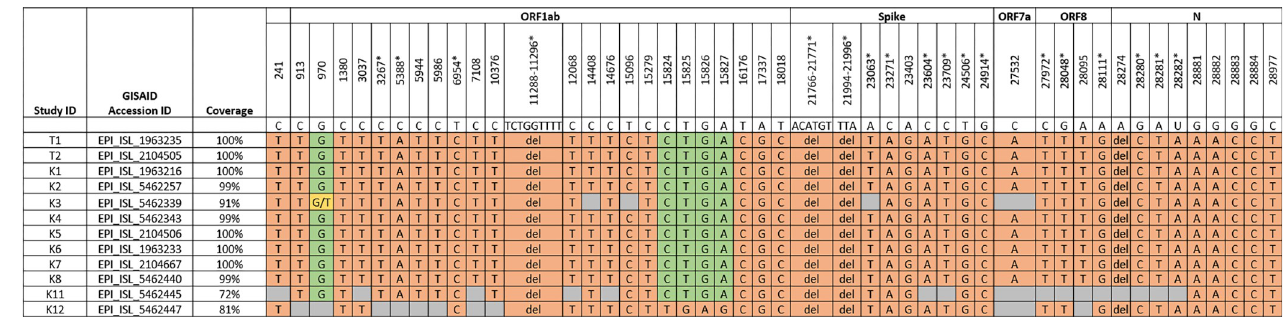
Fig 4. Virological analysis of positive cases by SARS-CoV-2 full genome sequencing. Mutations in comparison to the reference sequence (NC_045512) are highlighted in orange. Green fields indicate no mutation; grey fields indicate insufficient genome coverage; and yellow fields indicate mixed viral population of the two nucleotides given. Numbers indicate nucleotide positions; asterisks ( � ) mark lineage-defining mutations for the Alpha variant. ID: Identifier, GISAID: Global Initiative on Sharing Avian Influenza Data, Kx: Kid x, Tx: Teacher x.